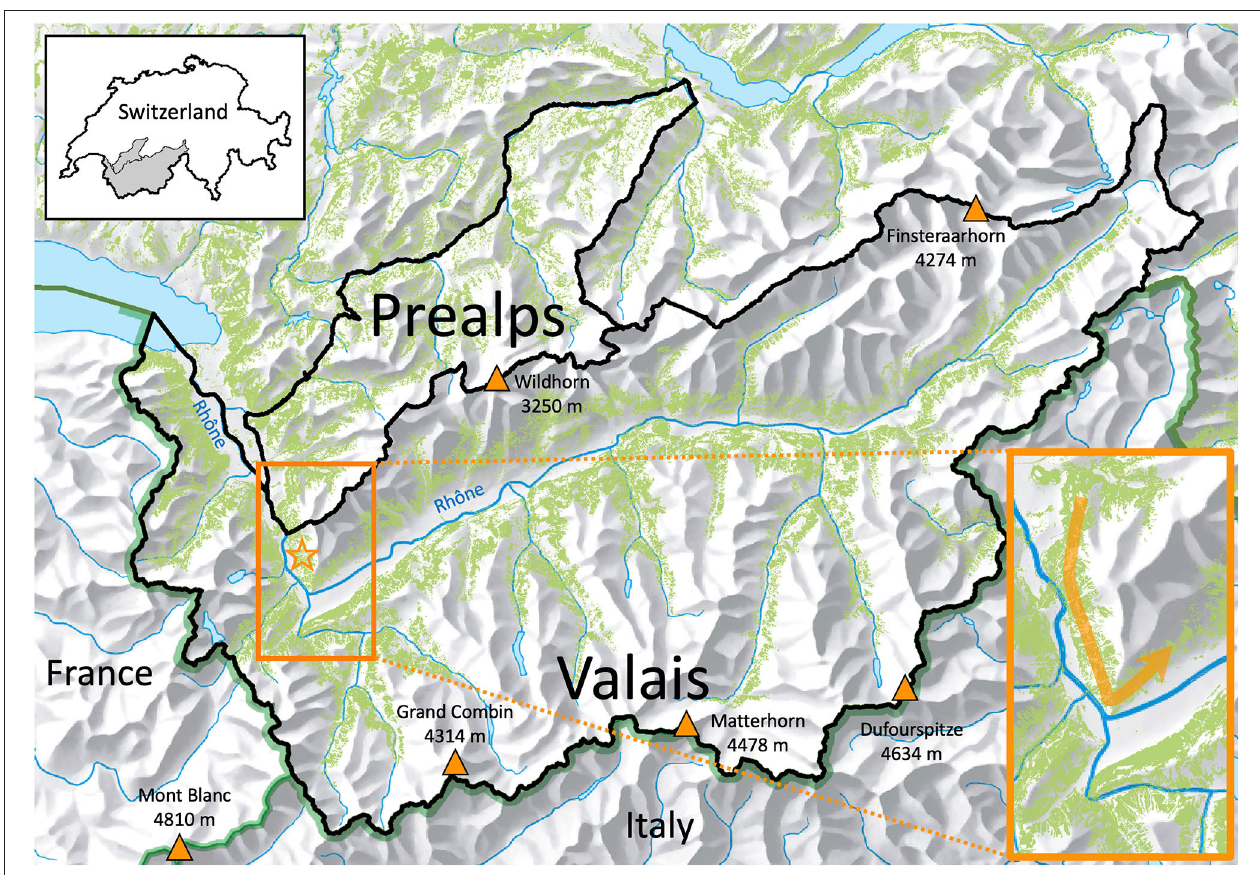
FIGURE 1 | The forest cover (in green) continuum of southwestern Switzerland (forest cover not shown for France and Italy) depicting the distribution of main lynx habitat. Valais is enclaved within high mountain ranges culminating at more than 4,000m a.s.l., both in the north and south. This isolates the Valais lynx population, with little connectivity to the north (where dense lynx populations occur), east and south (Italy). The forest continuum is higher in western Valais, with an important dispersal corridor linking to the Prealps, where lynx thrive, and France, south of the Rhône river, where lynx are rare. The main dispersal corridor (orange arrow) into the Upper Rhône valley (Valais) from the thriving lynx population in the Prealps is shown in the inset. The star indicates the location of the network of 17 illegal neck-snare traps found in the present study (see also Figure 6 ).